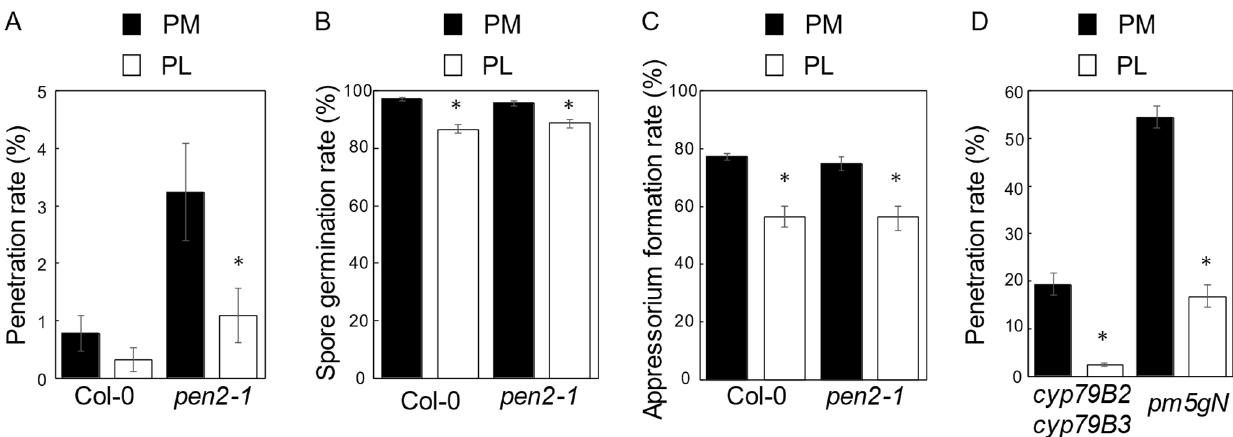
Figure 2. Quantitative analyses of penetration resistance to P. oryzae in Arabidopsis plants inoculated in the evening. ( A ) Mean frequency of P. oryzae penetration into Col-0 (wild-type) and pen2-1 plants at 72 h post-inoculation (hpi) expressed as a percentage of the total number of infection sites. ( B ) Spore germination rates on Col-0 (wild-type) and pen2-1 leaves at 72 hpi. Rates are expressed as a percentage of the total number of conidia. ( C ) Appressorium formation rates on Col-0 (wild-type) and pen2-1 leaves at 72 hpi. Rates are expressed as a percentage of the total number of conidia. ( D ) Mean frequency of P. oryzae penetration into cyp79B2 cyp79B3 and pen2-1 mol2 pmr5 gl1 NahG ( pm5gN ) plants at 72 hpi expressed as a percentage of the total number of infection sites. Values are expressed as mean ± standard error from three independent experiments, each containing six biological replicates ( n = 18). Black bar: PM inoculation; white bar: PL inoculation. Values marked with asterisks (PL inoculation) are significantly different from respective PM inoculation-controls (Student’s t -test; p < 0.05).